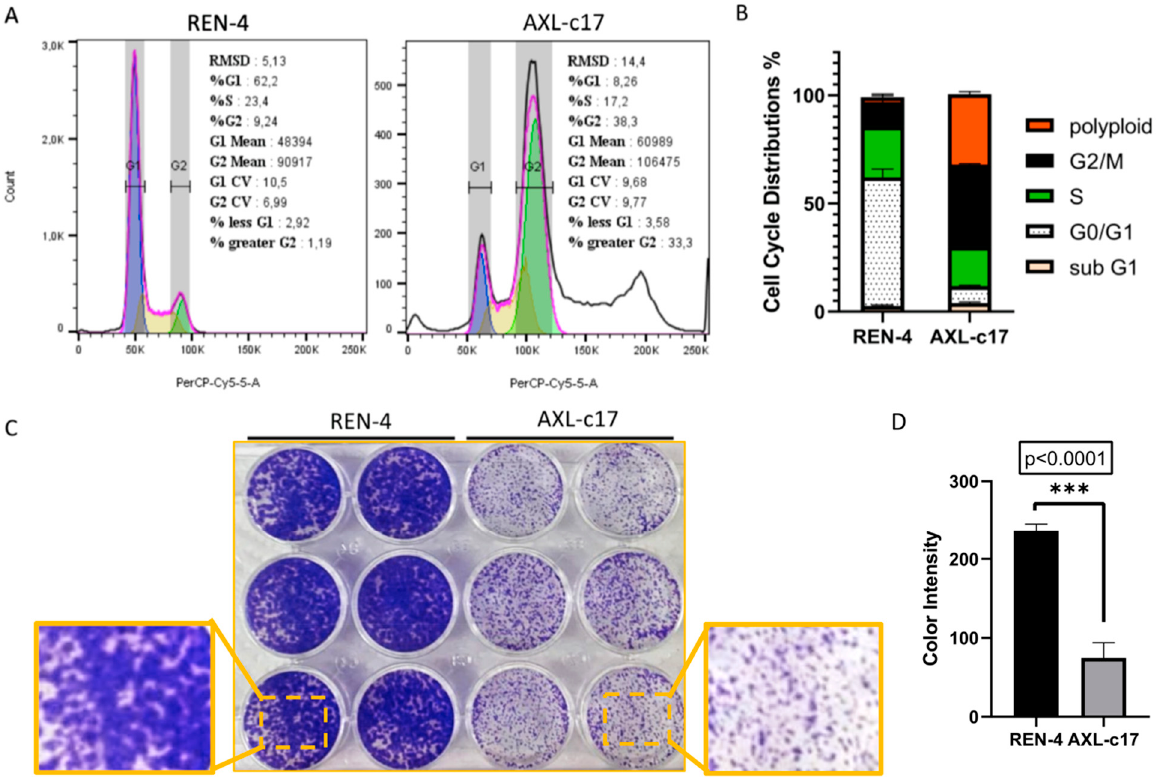
Figure 3. Cell cycle and colony formation of control and AXL knock-out cells. ( A ) DNA content from cell cycle analysis of REN-4 (left) and AXL-c17 (right) were shown. ( B ) Percentage of cell cycle distribution of both REN-4 and AXL-c17 cells. ( C ) Colony formation of REN-4 and AXL-c17 cells. Left 6 wells, and right 6 wells depict REN-4 and AXL-c17 cells, respectively. The focused area was displayed with dashed lines. ( D ) The color intensities of colony formations of REN-4 (black) and AXL-c17 (gray) were calculated by Image J. (*** p > 0.0001).